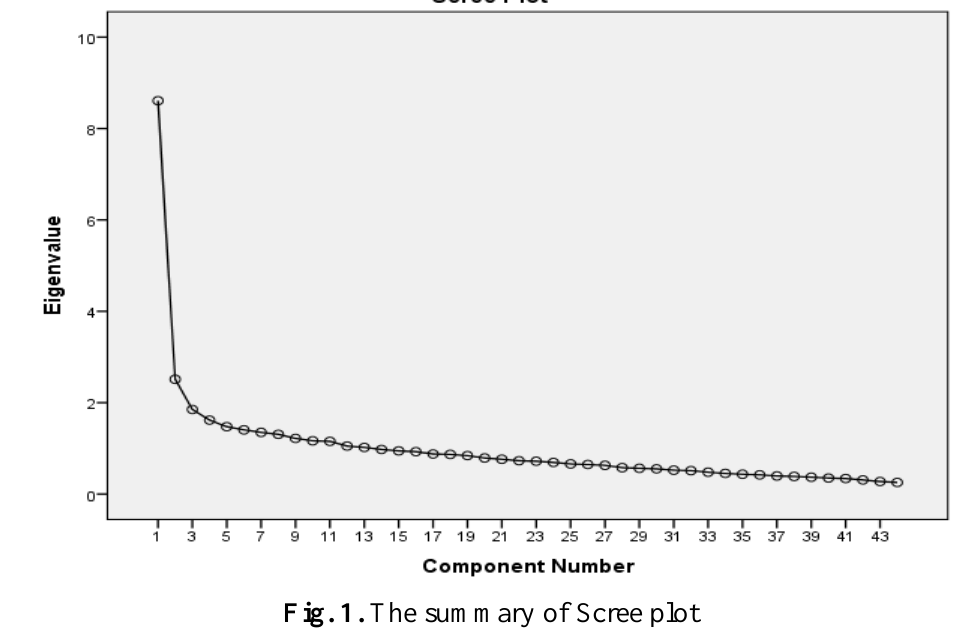
Fig. 1. The summary of Scree plot